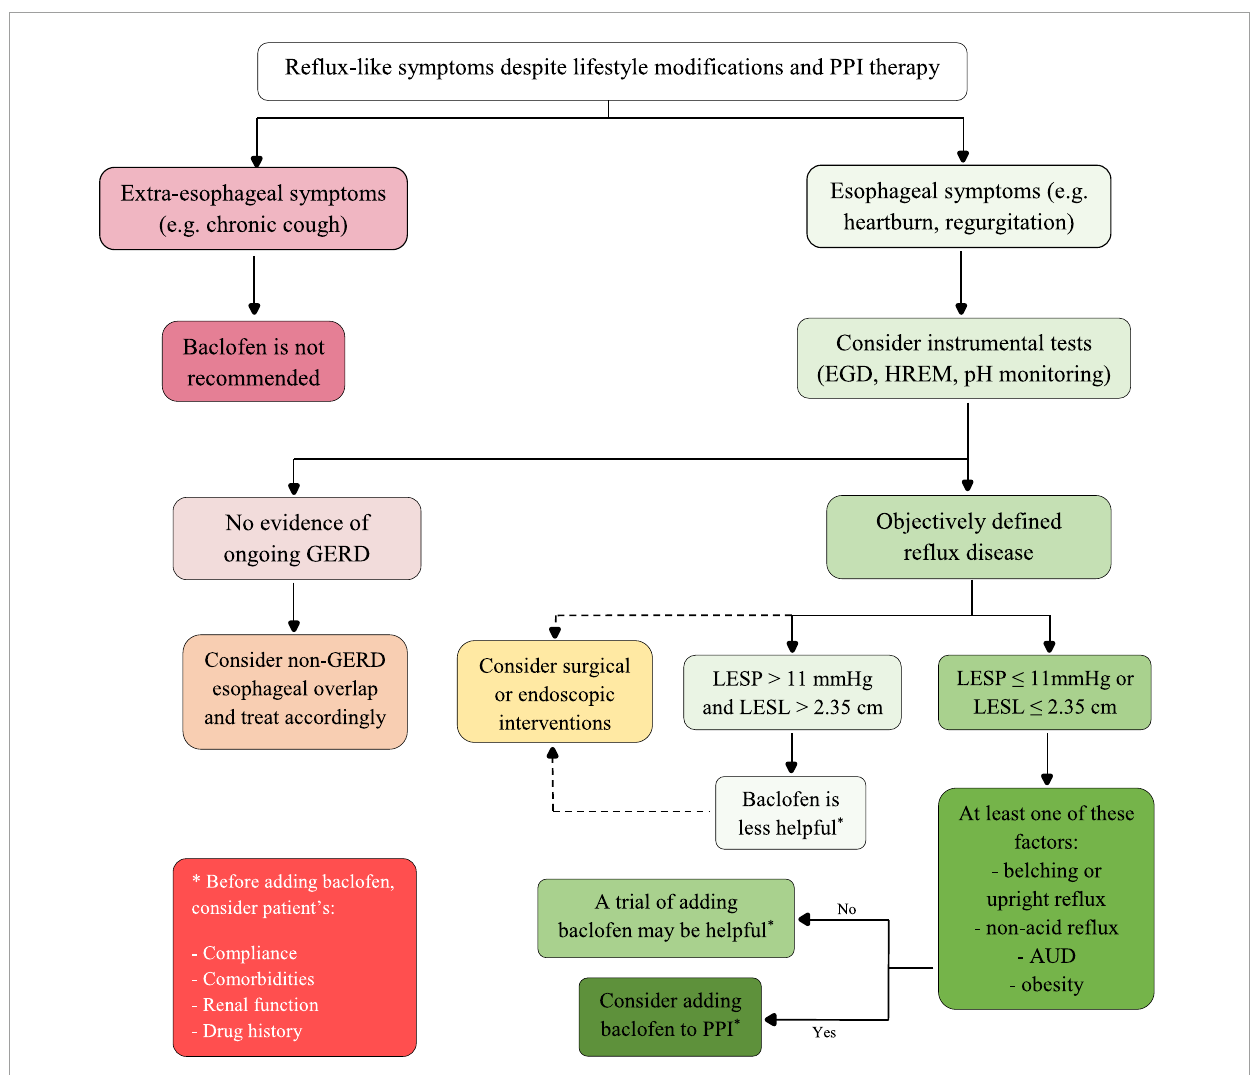
FIGURE2 Suggested algorithm for administration of baclofen for refractory reflux disease. AUD, alcohol use disorder; EGD, esophagogastroduodenoscopy; GERD, gastroesophageal reflux disease; HREM, high resolution esophageal manometry; LESL, lower esophageal sphincter length; LESP,